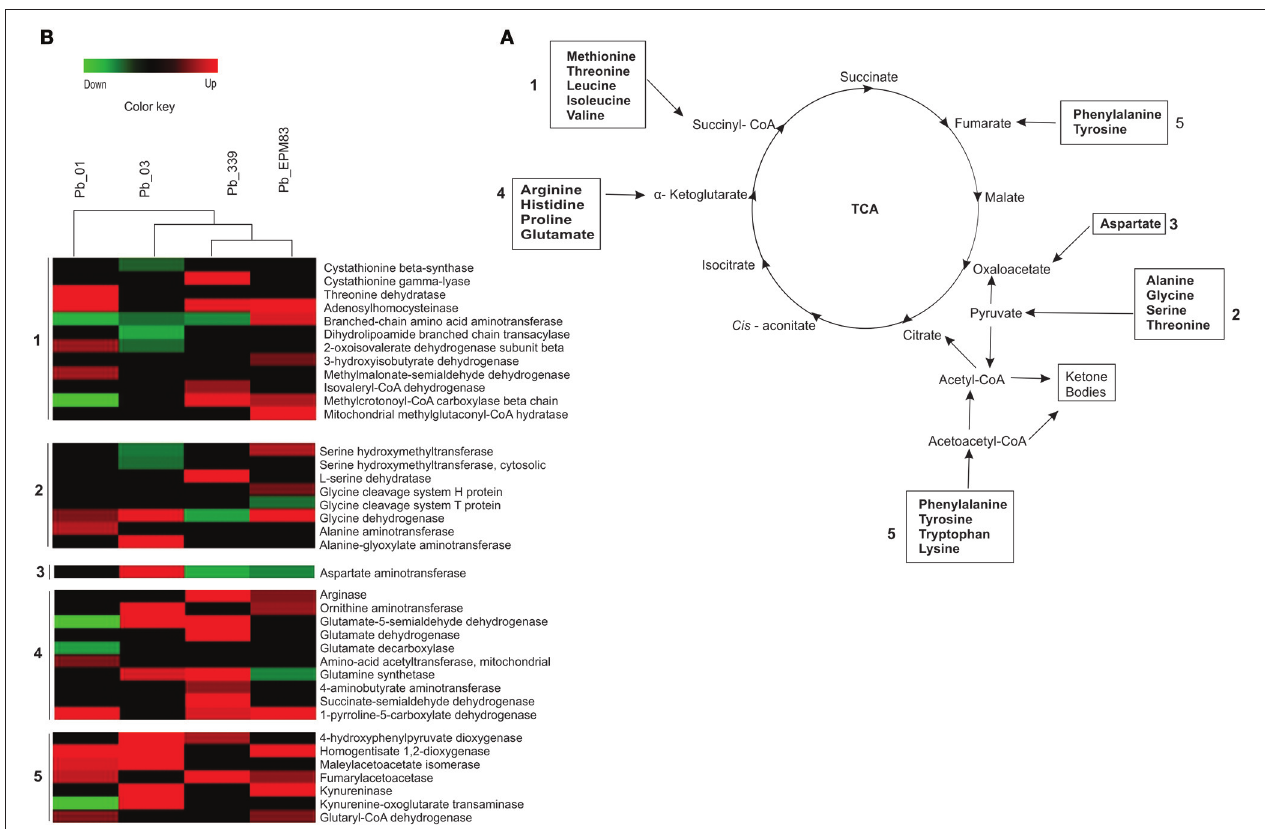
FIGURE 7 | Comparison of protein profiles related to amino acid catabolism in P. lutzii and isolates of P. brasiliensis . Dataset comparisons were carried out as cited in Figure 2 legend. (A) Changes in expression levels in yeast cells incubated with acetate in Pb 01, Pb 03, Pb 339, and Pb EPM83 are represented in a heat map format. (B) Representative diagram of the amino acid catabolism pathways depicting down-regulated (green) and up-regulated (red) proteins in the isolates, as cited above. Black indicates that no significant difference was observed.